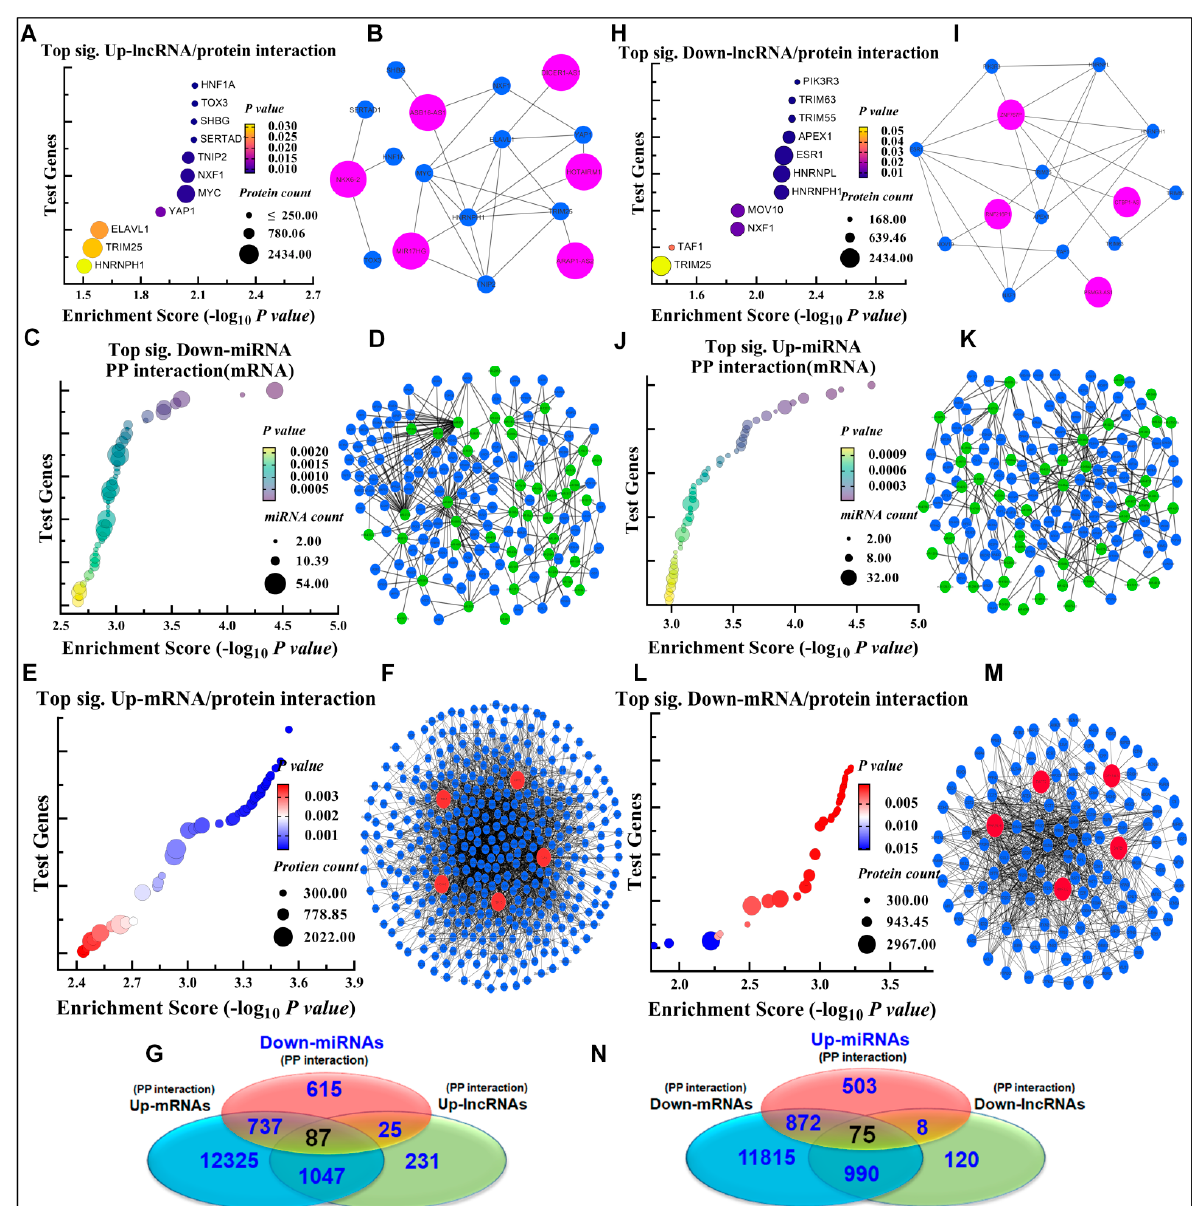
Figure 3. RNA–protein binding networks of oncogenic and tumor suppressive axes. ( A ) Top up- lncRNAs/protein–protein (PP) interaction, demonstrating considerable one seed interaction through the examined tested genes. ( B ) The top up-lncRNAs and PP interaction network, which illustrates all the roles of up-lncRNAs and PP interactions as network panels. ( C ) Top 50 down-miRNAs that bind to mRNA. ( D ) Connections between down-miRNAs and mRNA in the top 50 partners. ( E ) The top 5 up-mRNAs interacting with PP interactions (one seed). ( F ) A connection between the PP network (one seed) and the top five down-mRNAs. ( G ) Venn diagram illustrating the shared proteins interacting with the oncogenic axis components, 87 proteins are interacting with the oncogenic axis components. ( H ) The linkage between top down-regulated lncRNAs and PP interaction (one seed). ( I ) The network panel of PP interaction with the top down-regulated lncRNAs. ( J ) The highly significant top 50 interactions of up-miRNAs with their partners (mRNA). ( K ): Up-miRNA–PP interaction network (mRNA) (top 50 interactions). ( L ) The highly significant top 5 interactions of down-mRNAs with their protein partners. ( M ) The network connections between the PP